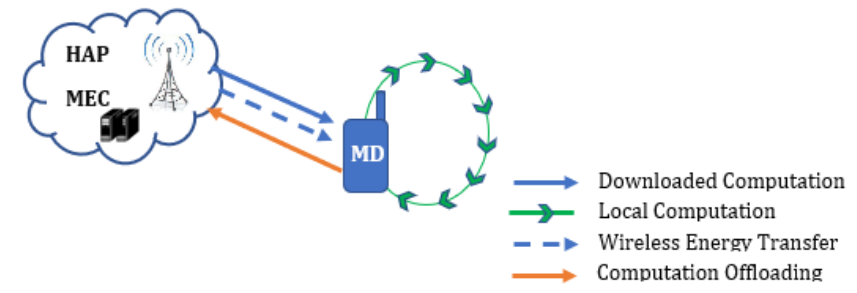
Figure 1. Wireless energy powered MEC system with one